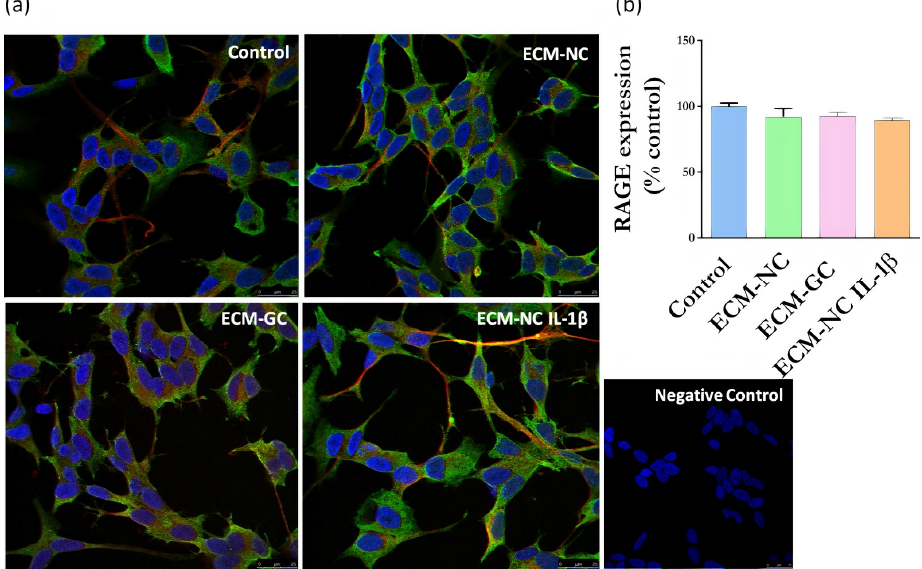
Figure 6. ( a ) Representative images of immunofluorescence of RAGE expression. Neuronal class β -III tubulin (red) 1:500; Hoechst-33342 was used to stain nuclei (blue) 1:3000; RAGE receptor (green) 1:200 in control cells (differentiated/ without ECM) and cells treated with ECM-NC, ECM-GC, ECM-NC IL-1 β . Negative control of immunostaining. Magnification 40×. Scale bar: 25 µm. ( b ) Relative quantification of immunostaining for RAGE representing the ratio between the experimental and the control group. The data were analyzed by t -test. The data represent three independent and similar assays. Data were analyzed by one-way ANOVA with post hoc testing by Dunnett p > 0.05).